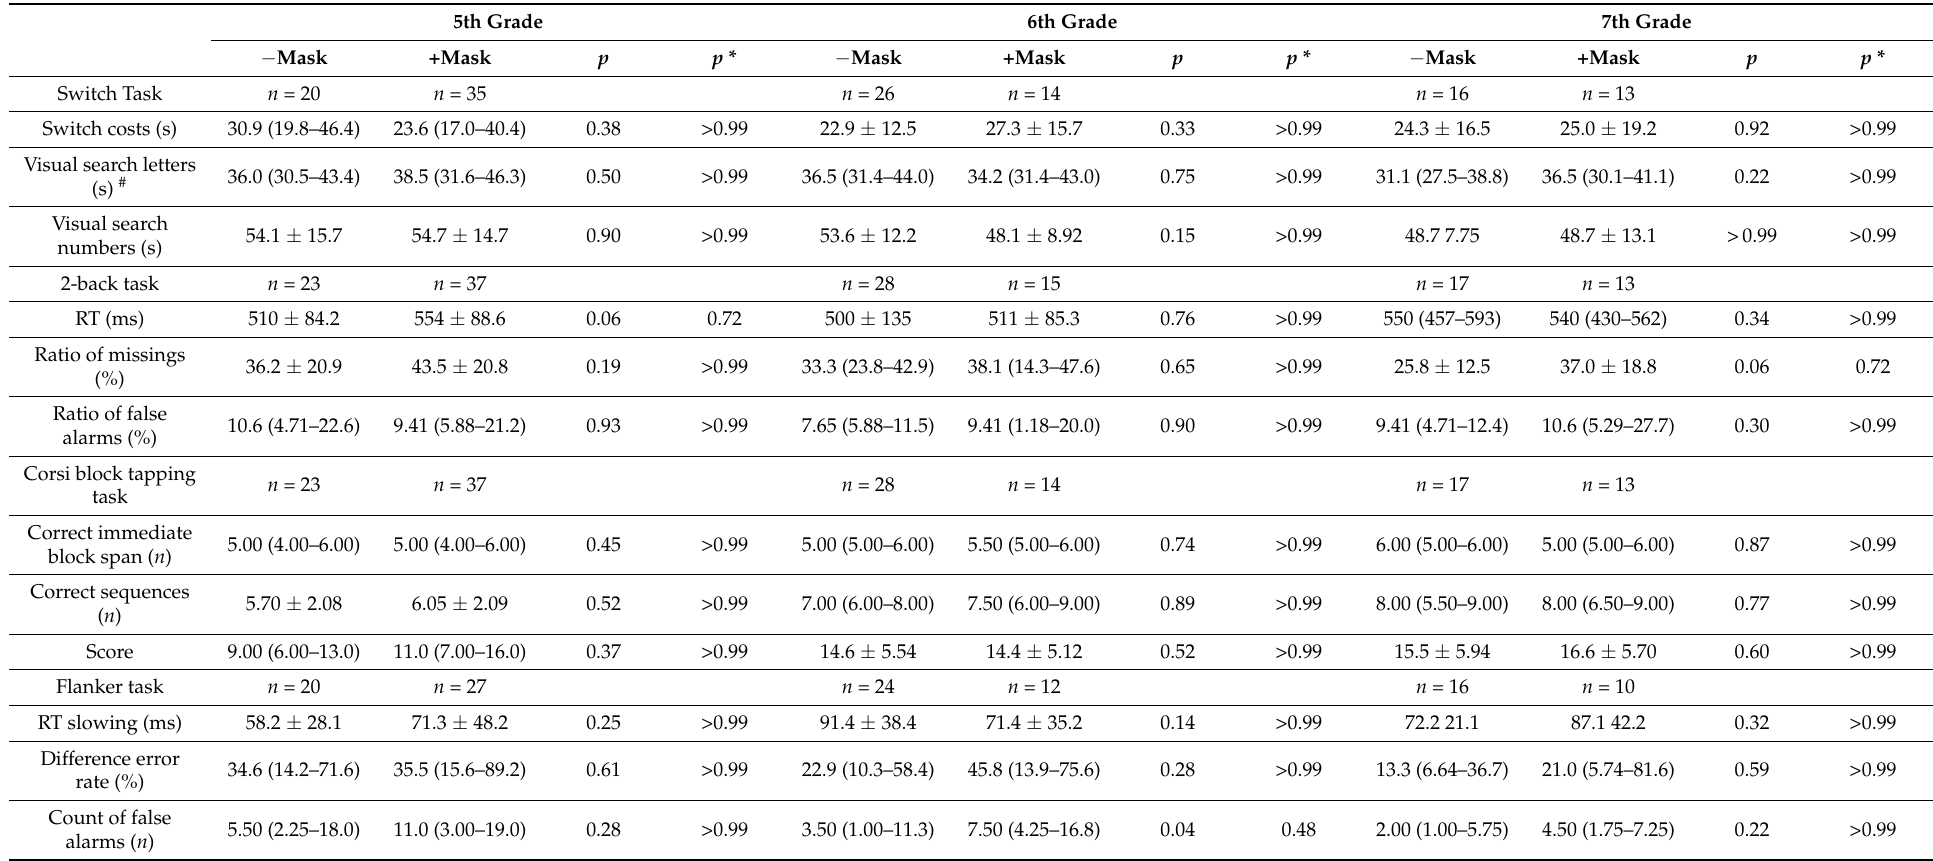
Table 3. Cognitive performance of children without ( − Mask) and with a mask (+Mask)—allocation by grade